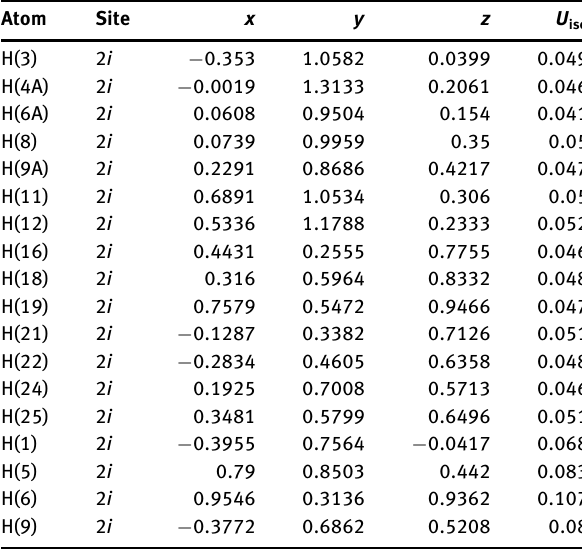
Table 2: Fractional atomic coordinates and isotropic or equivalent isotropic displacement parameters (Å 2